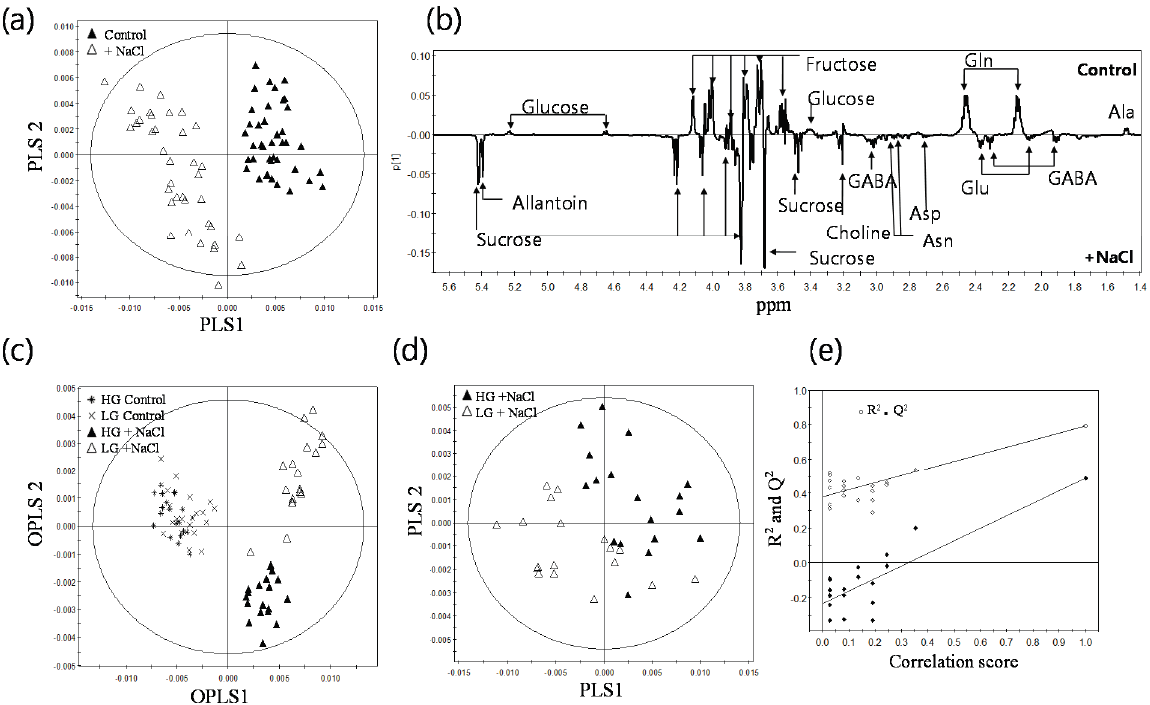
Figure 3. Multivariate statistical analysis of 1 H-NMR data depending on the growth type and salt response of rice roots. ( a ) PLS-DA score plot from total of 76 samples obtained from the control and 38 mild salt-treated genotypes; ( b ) PLS-DA loading plot of the control and salt-treated groups; ( c ) OPLS/O2PLS-DA score plot of four groups: HG control, LG control, HG + salt, LG + salt; ( d ) PLS-DA score plot to distinguish the differences between the salt-treated HG and LG groups; ( e ) The validation plot of permutation test for the PLS-DA of ( d ). The R 2 Y intercept is at 0.381 and the Q 2 Y intercept is at − 0.218. The circles in the OPLS/O2PLS-DA and PLS-DA score plots indicate the tolerance ellipse based on Hotelling’s T 2 . The X -axis denotes correlation scores between original and permuted